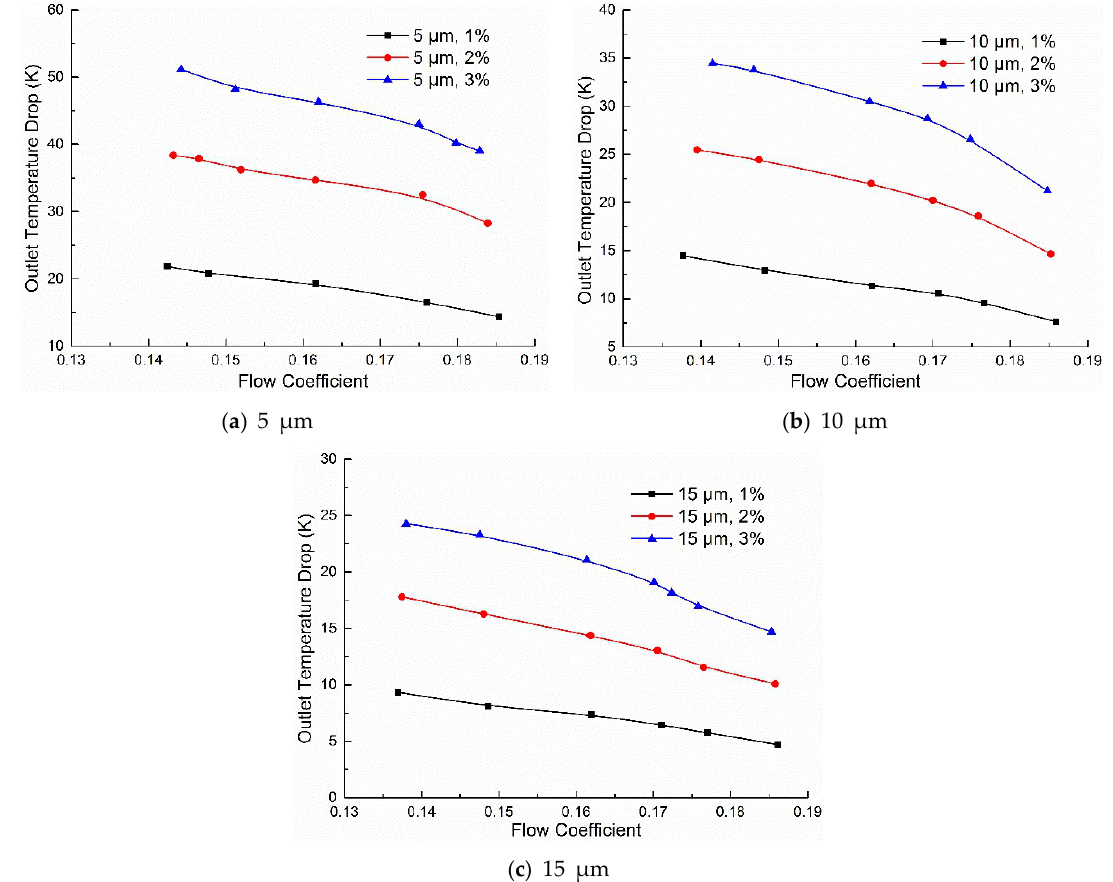
Figure 9. Outlet temperature drop of wet compression